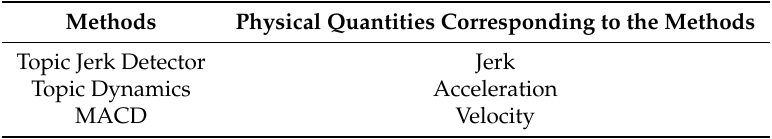
Table 1. The correspondence between the methods and physical qualities.